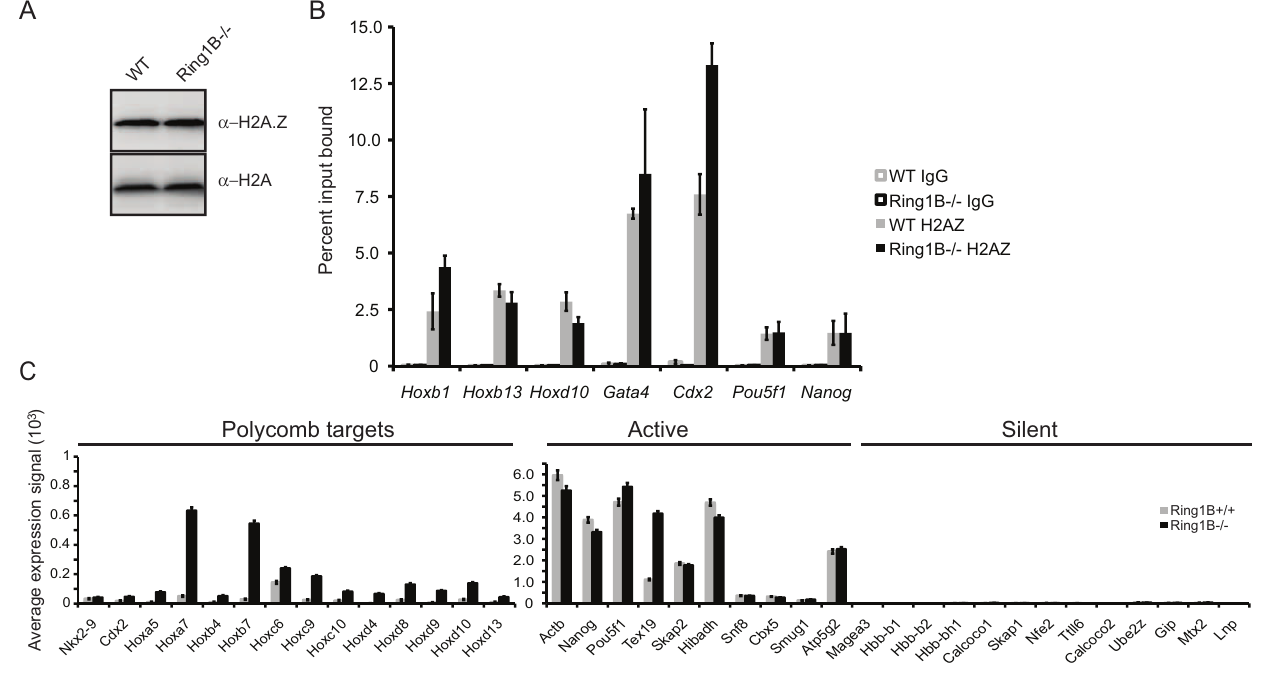
Figure 2. H2A.Z distribution at polycomb targets in the absence of Ring1B. A) Immunoblot for H2A.Z and H2A in Ring1B 2 / 2 and matched WT (Ring1B + / + ) ESCs. B) ChIP for H2A.Z at the promoters of Hoxb1, Hoxb13, Hoxd10, Cdx2, Pou5f1 and Nanog, assayed by qRT-PCR, in WT ( + / + ) (grey) or Ring1B 2 / 2 cells (black). Enrichment is shown as mean % input bound 6 SD over two biological replicates (6 technical replicates). IgG is shown in white bars with grey or black borders 6 SD. C) Average expression signals of active, silent and polycomb target genes in WT ( + / + ) (grey) and Ring1B 2 / 2 (black) from four biological replicates hybridized to MouseWG-6 v2.0 Expression BeadChips 6 s.e.m.